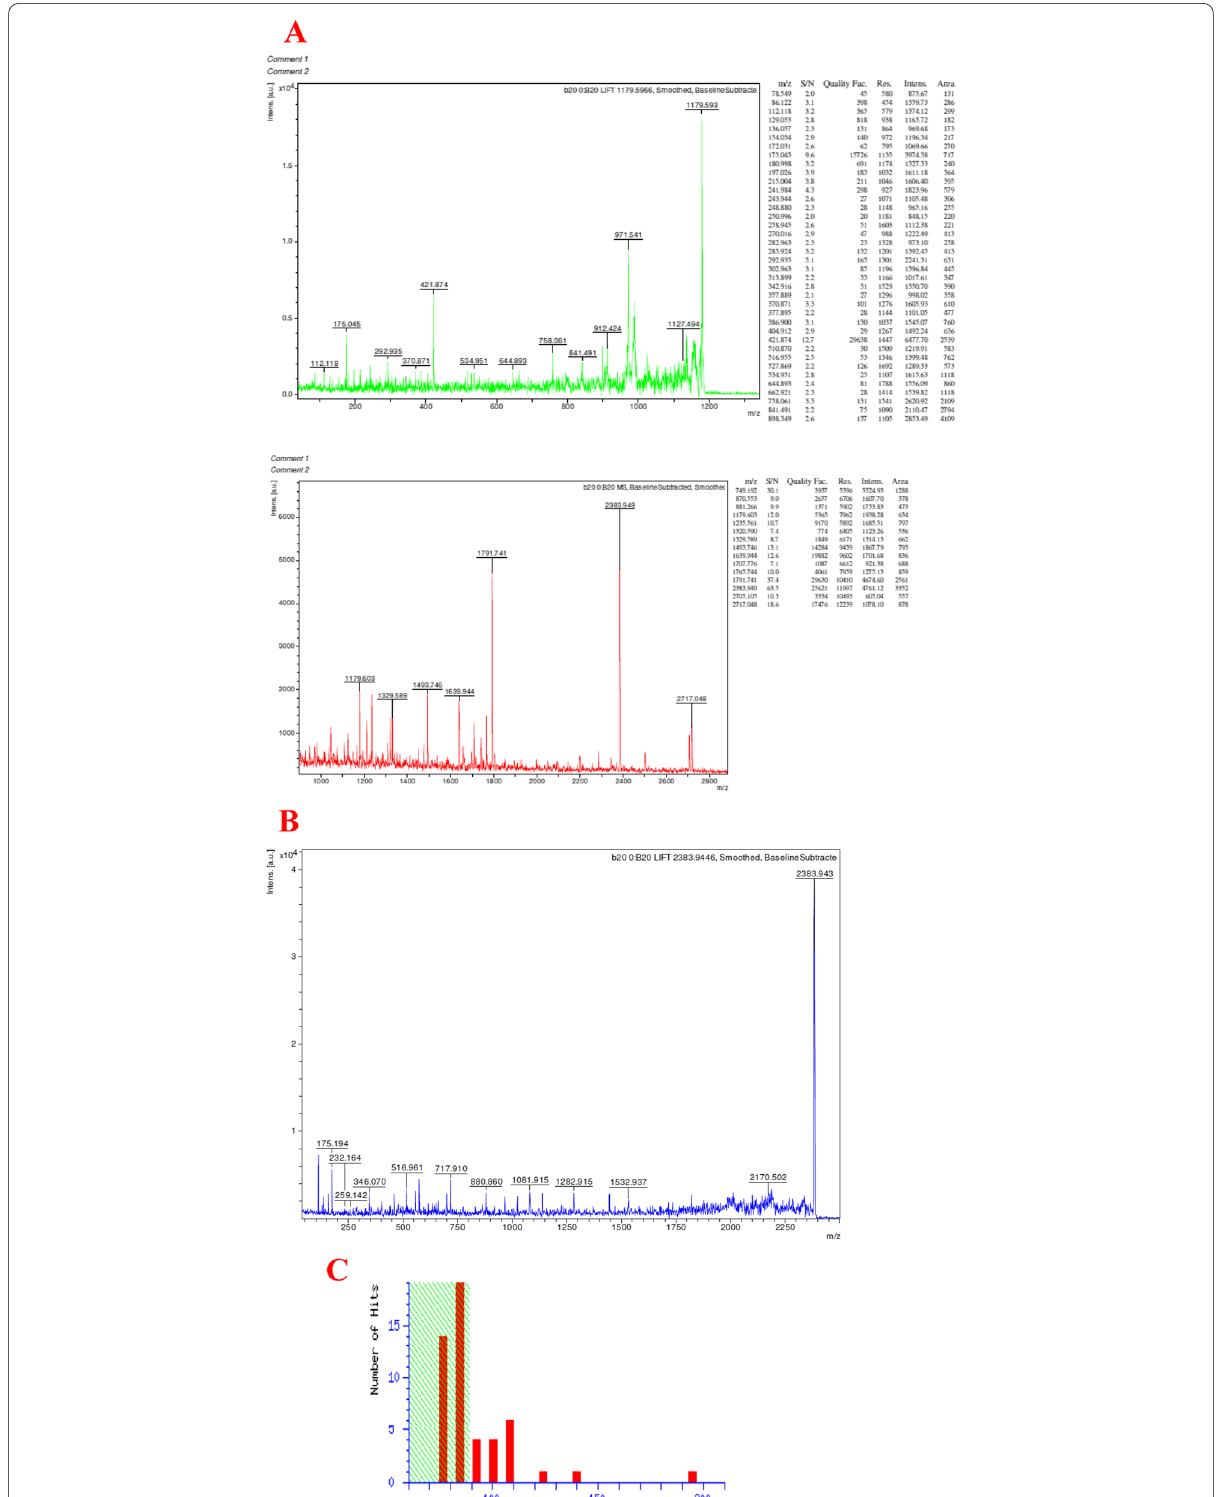
Fig. 5 MALDI-TOF analysis: Intact mass determination ( A ); protein MS/MS 2383 spectrum ( B ); Mascot score histogram of the band corresponding to 23 kDa ( C